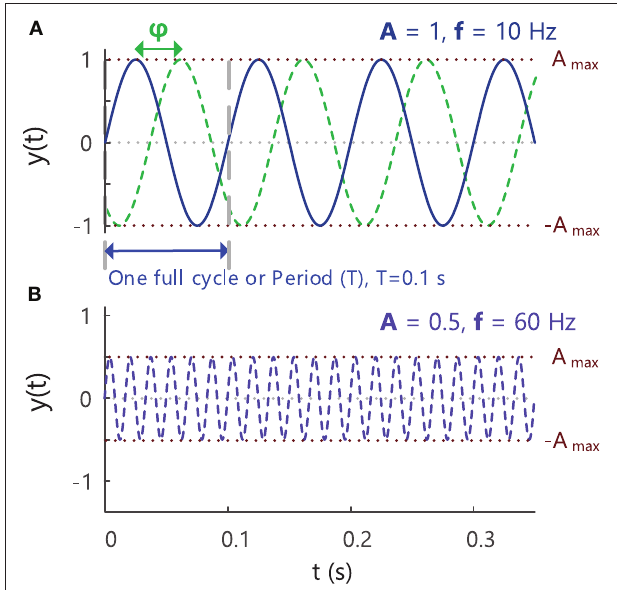
FIGURE 4 | (A) A sine wave with an amplitude of 1, frequency of 10Hz and phase of zero, showing the variation in the signal over time. A second sine wave with the same amplitude and frequency but different phase (– π /2 = − 90 ◦ ) is indicated with the green dashed lines. As the value of a sinusoidal signal at any point in time is based on circular motion, the phase of a signal is expressed as an angle in radians or degrees (start of period = 0 ◦ , end of period = 360 ◦ or 2 π radians). (B) A sine wave with an amplitude of 0.5, frequency of 60Hz and phase of zero. See Example (ii) in Tutorial